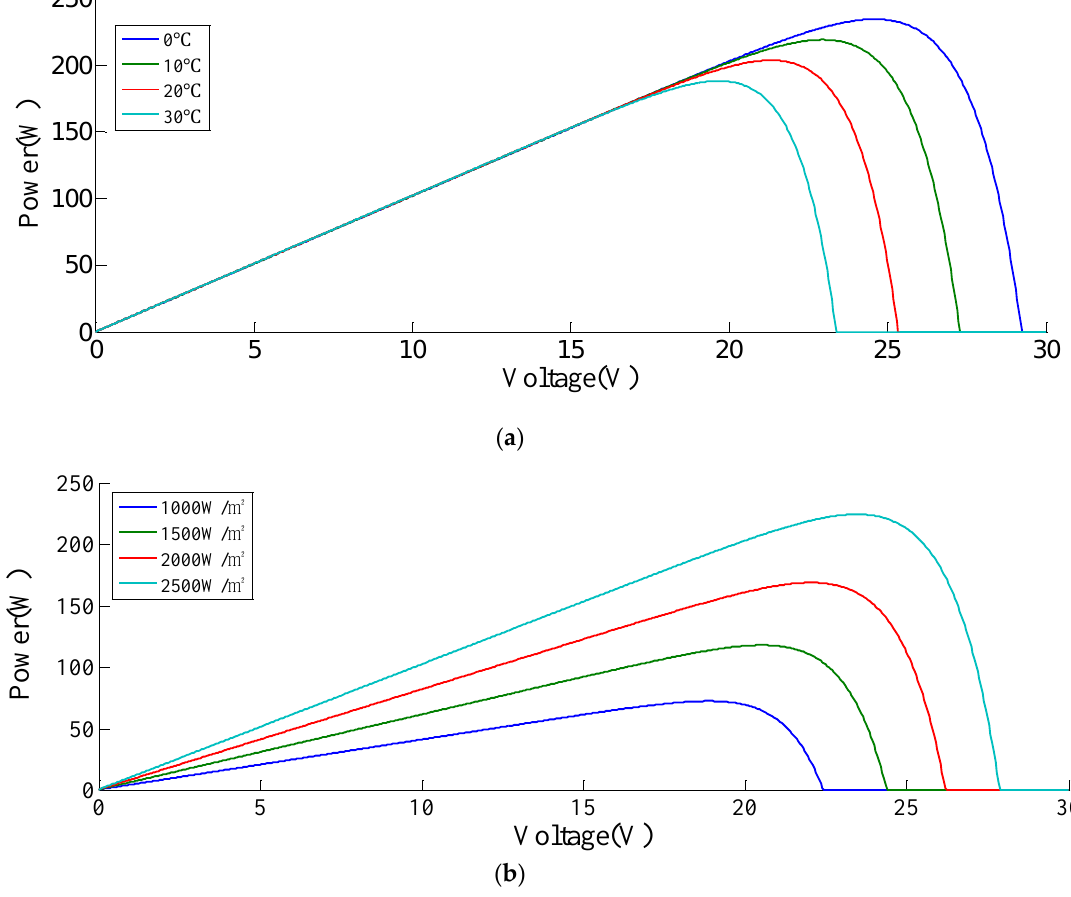
Figure 3. P-V output characteristics of PV modules in different environments. ( a ) P-V output characteristics of PV modules under different temperatures at S = 1000 W/m 2 ( b ) P-V output characteristics of PV modules under different light intensity at T = 25 °C .